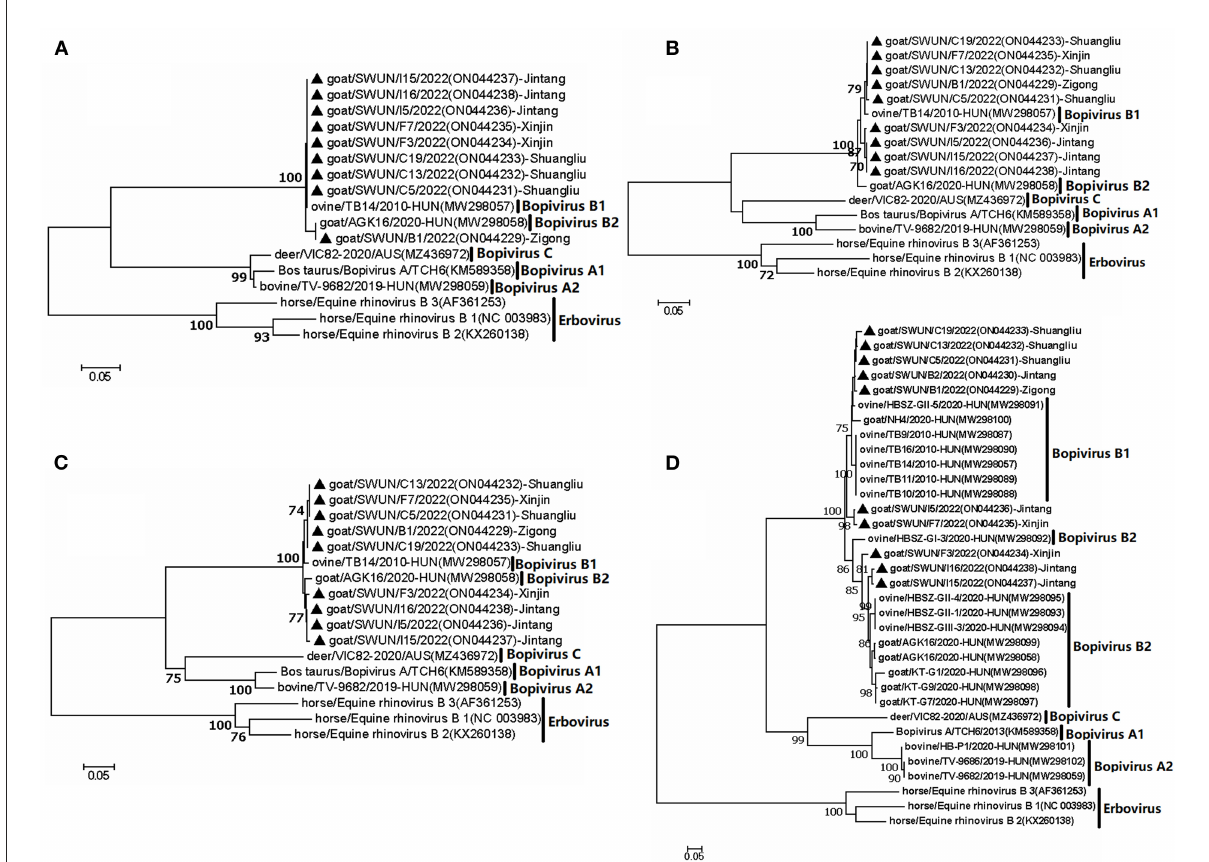
FIGURE1 Phylogenetic relationship of bopiviruses from this study with representative members from genus Bopivirus based on aa similarity of the complete VP4 (A) , VP2 (B) , VP3 (C) , and VP1 (D) . The trees were constructed using the neighbor-joining method in MEGA 7.0 program. The bootstrap values were calculated from 1,000 replications.The black triangles indicate that the corresponding sequences were from the strains in this study.